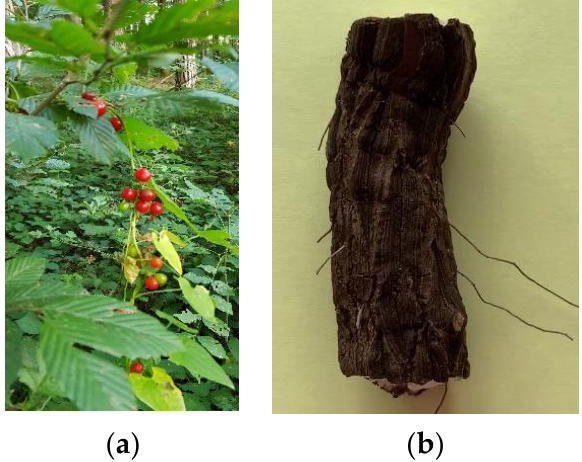
Figure 1. Tamus communis L. ( a ) aerial part; ( b ) rhizome ( authors’ photos ). In Bulgarian traditional medicine, the juice or macerate of the Tamus communis L.